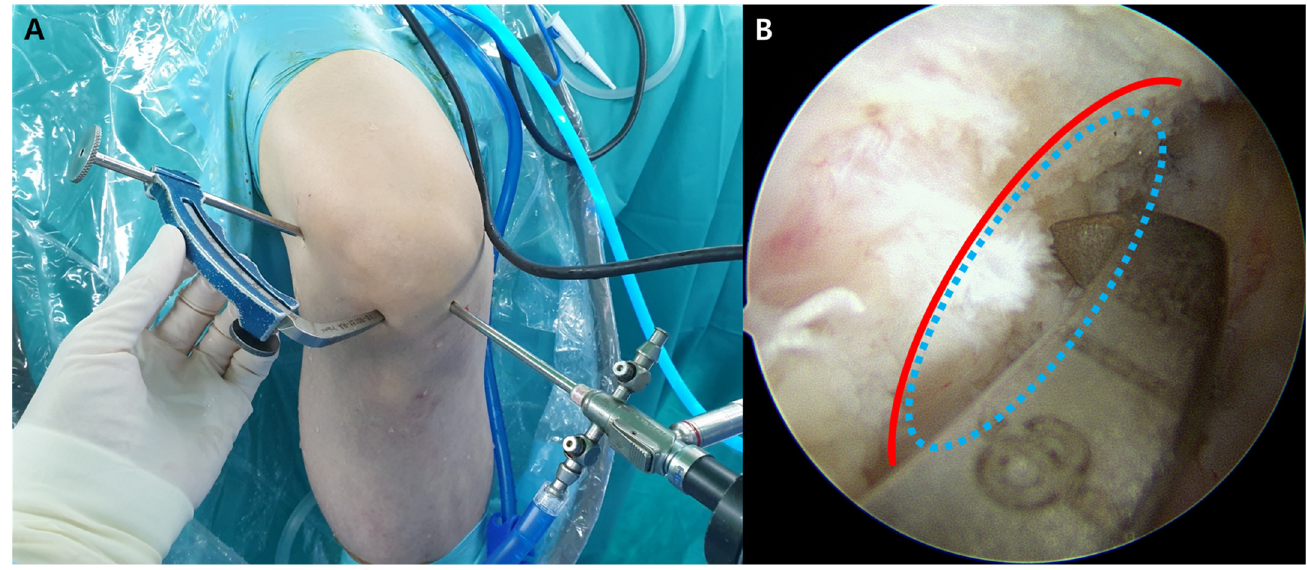
Figure 1. Creation of an anatomical femoral tunnel using the outside-in technique. ( A ) After palpation of the lateral femoral epicondyle, a small incision is made just proximal and posterior to the lateral femoral epicondyle. The guide’s angulation is adjusted to allow the tip of drill sleeve placement in the incision at the femoral footprint of the anterolateral ligament. ( B ) The tip of the femoral aiming guide is placed at the femoral footprint of the anterior cruciate ligament through the anterolateral portal under direct arthroscopic visualization through the anteromedial portal (red line, lateral intercondylar ridge (Resident’s ridge)); blue ellipse, femoral footprint of the anterior cruciate ligament).